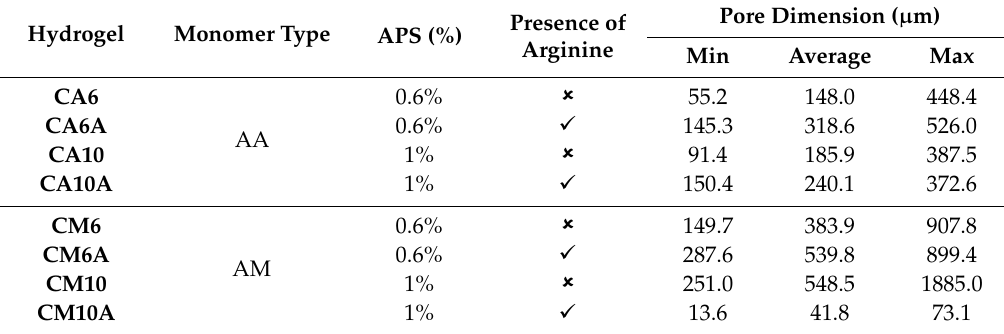
Table 2. Pore size variations with hydrogel composition.